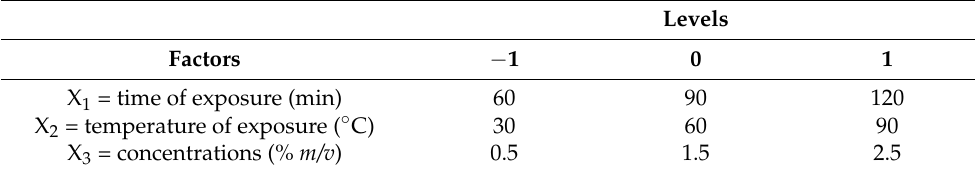
Table 3. Variation and variable levels for stability studies of Pouteria macrophylla extracts.